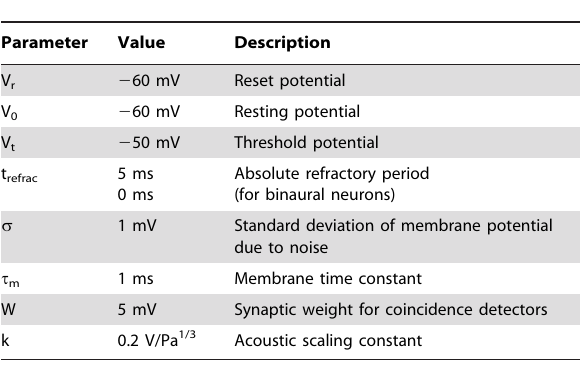
Table 1. Neuron model